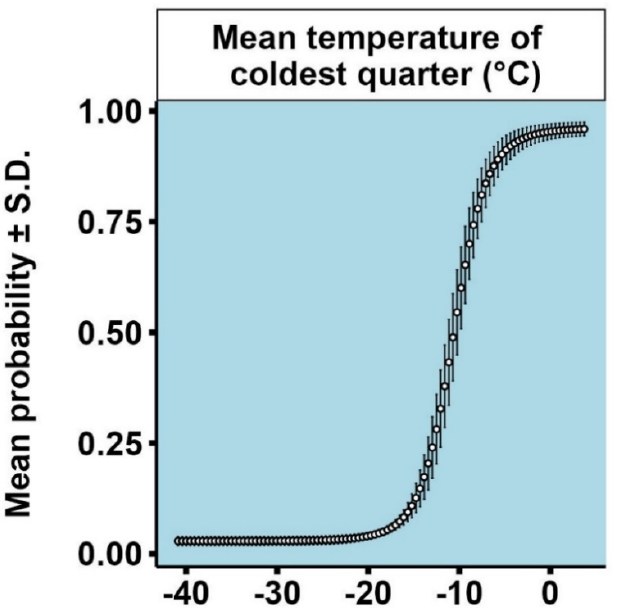
Figure 5. Mean probability ± S.D. of E. polonica presence at different values of the explanatory variable according to generalized linear models ( n = 60 per point).